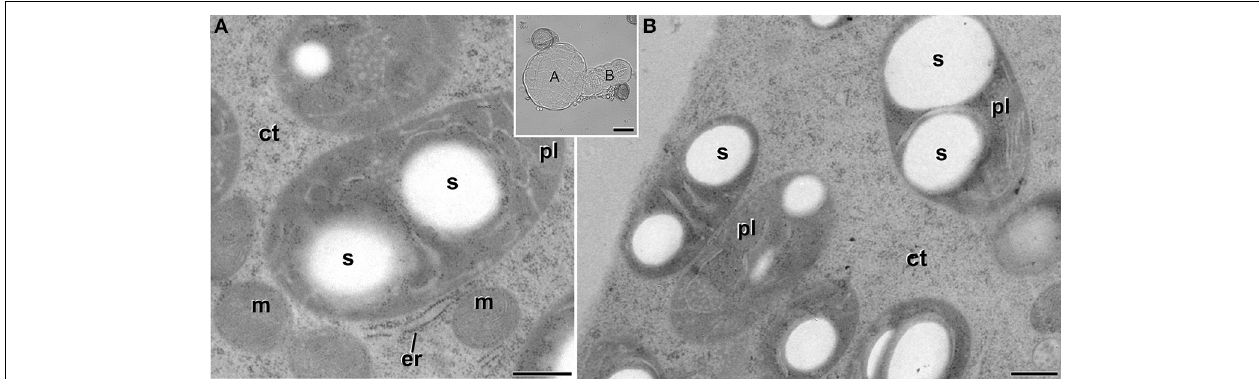
FIGURE 7 | Starch-containing plastids (pl) from B. napus globular MDEs. The inset shows a light microscopy section of a globular MDE where the embryo proper (A) and the suspensor (B) domains can be clearly